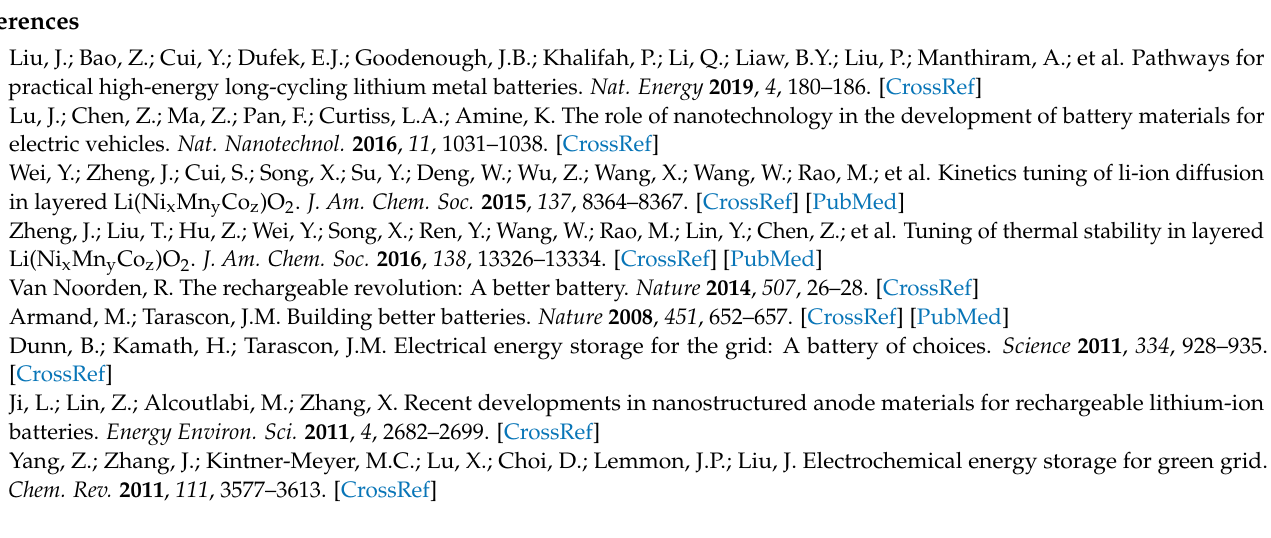
Figure S5: (a) 180 ◦ peeling test of electrodes based on different mass ratios of Si NPs, PAA and PED; (b) 20-round charge and discharge test of the electrodes mentioned above at 0.1 C; Figure S6: XRD spectra of Si NPs; Figure S7: SEM image of Si NPs; Figure S8: TEM image of Si NPs; Table S1: Electronic conductivity of PED, PAA and PVDF. The Supplementary Materials is available free of